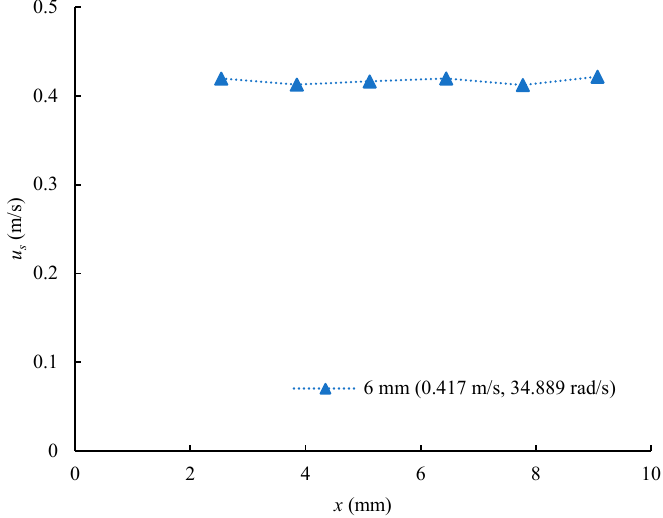
Figure 2. The trajectory of a 6 mm sphere.